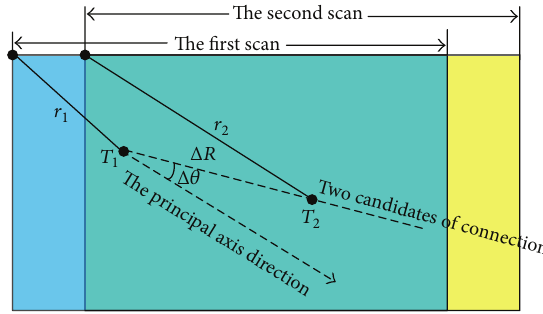
Figure 9: The tracking of